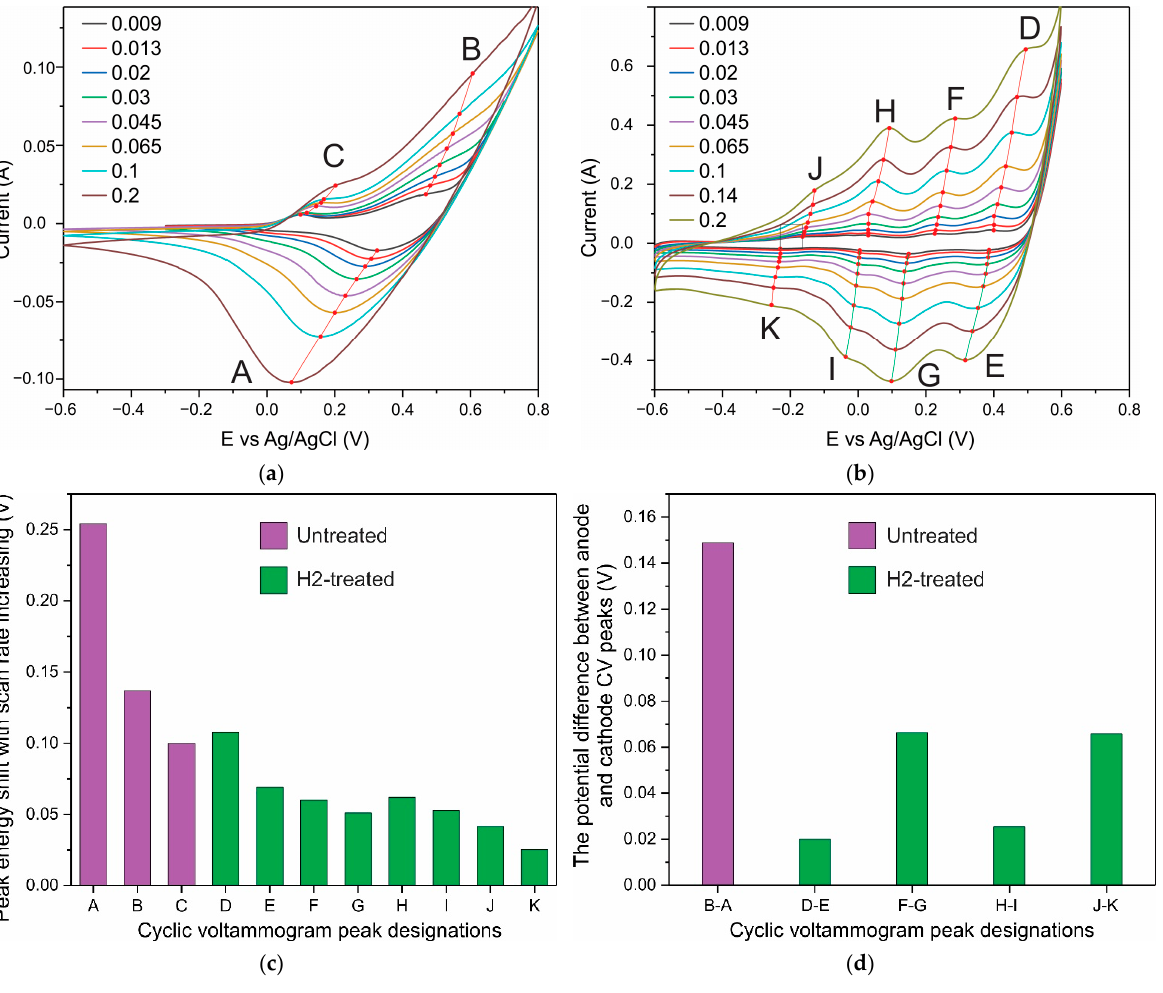
Figure 7. CV curves of the Co 3 O 4 NPs–NF untreated electrode ( a ) and H2-treated one ( b ); the shifts of peak energy upon the increase in the scan rate from 0.009 to 0.2 V s − 1 ( c ); the difference between the potential of anode and cathode peak determined at a sweep rate of 0.009 V s − 1 ( d